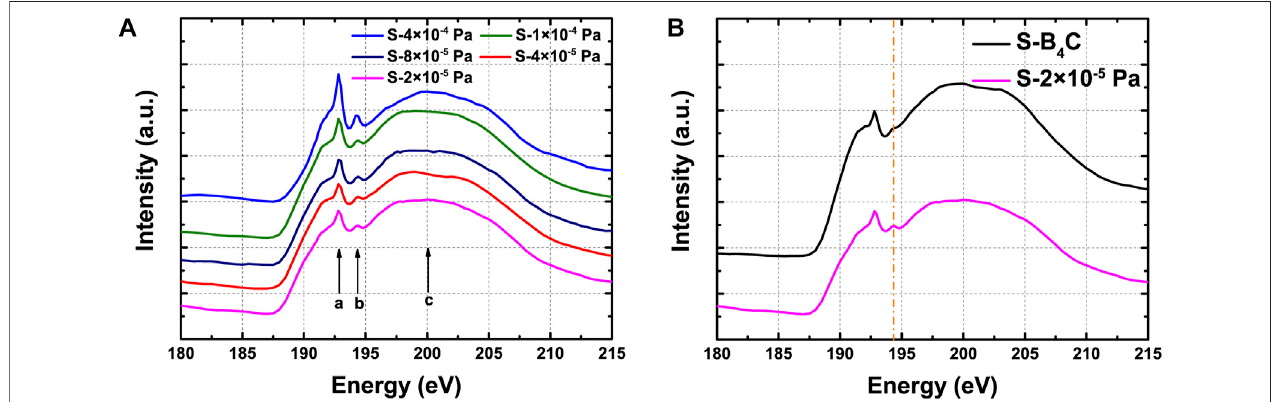
FIGURE4| The BK-edge X-ray absorptionnear-edgespectroscopy (XANES) spectra ofdifferent samples: (A) NiV/B 4 C MLs deposited withdifferentbackground pressures(S-4×10 − 4 ,S-1×10 − 4 ,S-8×10 − 5 ,S-4×10 − 5 ,andS-2×10 − 5 Pa). (B) NiV/B 4 C MLdepositedwith2×10 − 5 PaandB 4 Ccoatingdepositedwith6×10 − 5 Pa.